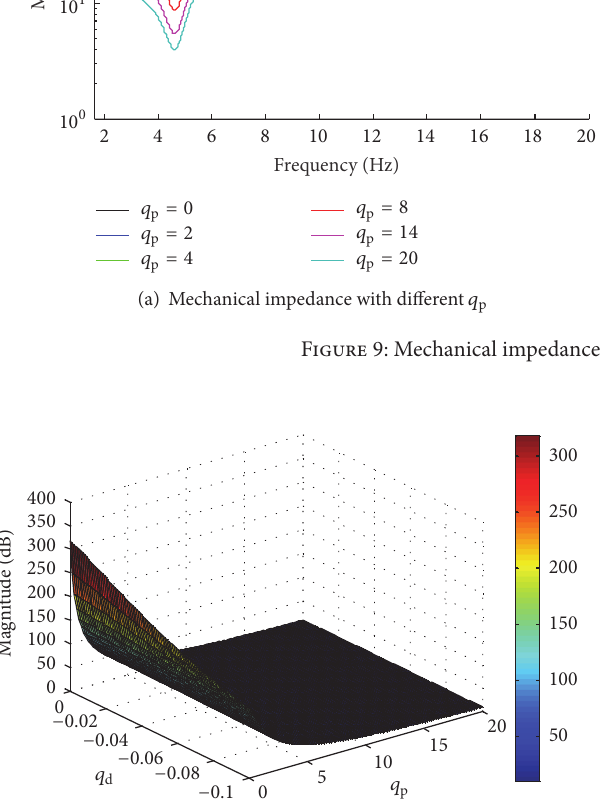
Figure10:Surfaceofmechanicalimpedanceat1.67 Hzversus 𝑞 p and 𝑞 d .